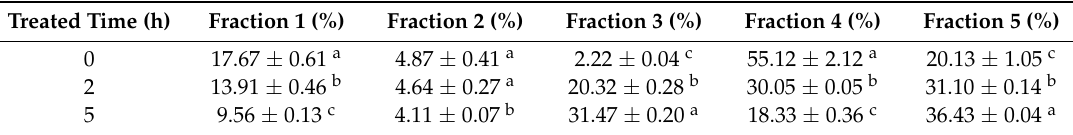
Table 4. Relative proportions of the five fractions of the water-soluble polysaccharides in longan juice before (0 h) and after enzyme treatment for 2 h and 5 h *.